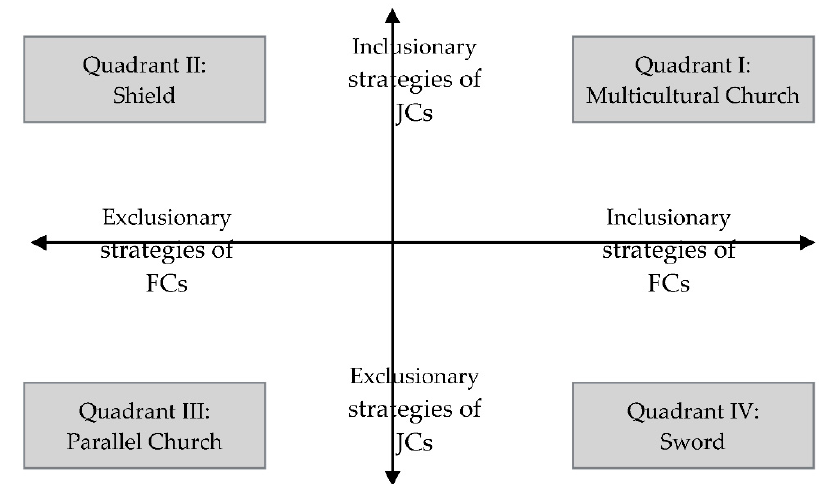
Figure 2. A proposed heuristic device: The ecclesial history of Filipino-Catholics with the host group as rendered in a Cartesian plane.